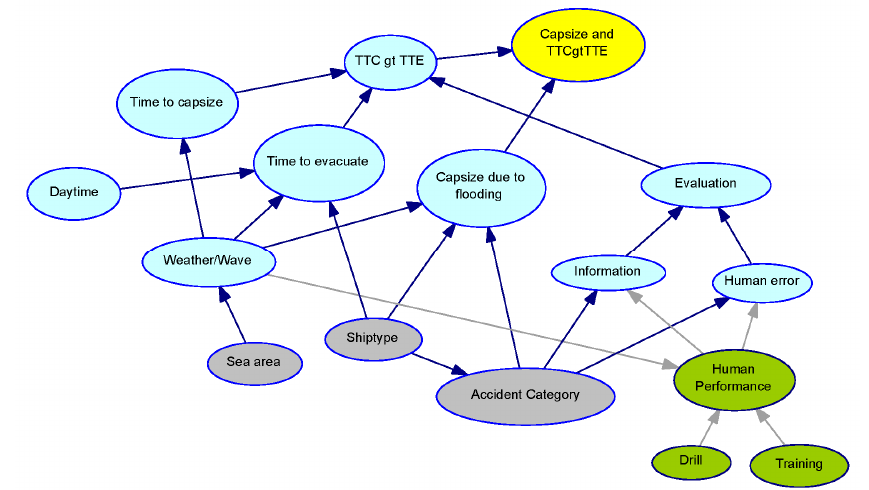
Figure A11. A Bayesian network for capsizing and evacuation in flooding accidents (09b).